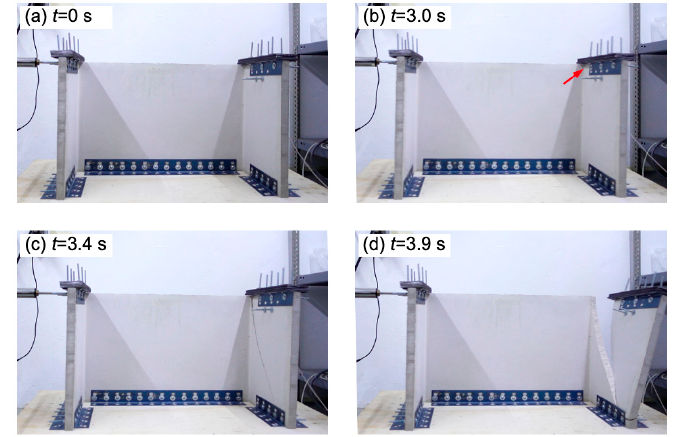
Figure 9. Collapse sequence of PFC specimen #1: ( a ) start of the test; ( b ) formation of the first visible crack on the right flange (indicated by a red arrow); ( c ) development of the crack; ( d ) collapse of the right flange.